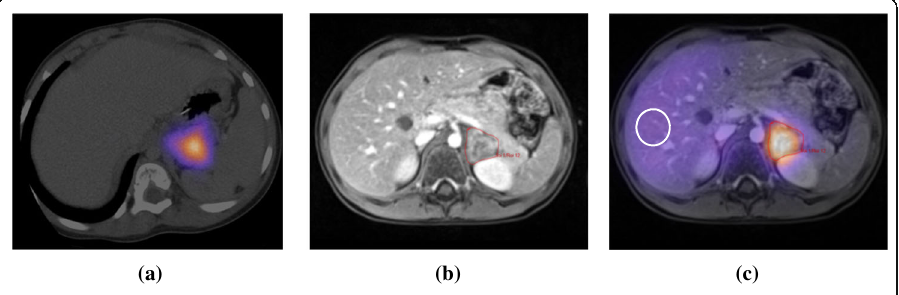
Fig. 6 Image data depicting SPECT/CT ( a ), MRI alone ( b ) and fused SPECT/MRI ( c ). The lesion can clearly be seen as the volume with intense uptake adjacent to the left kidney (delineated in b and c